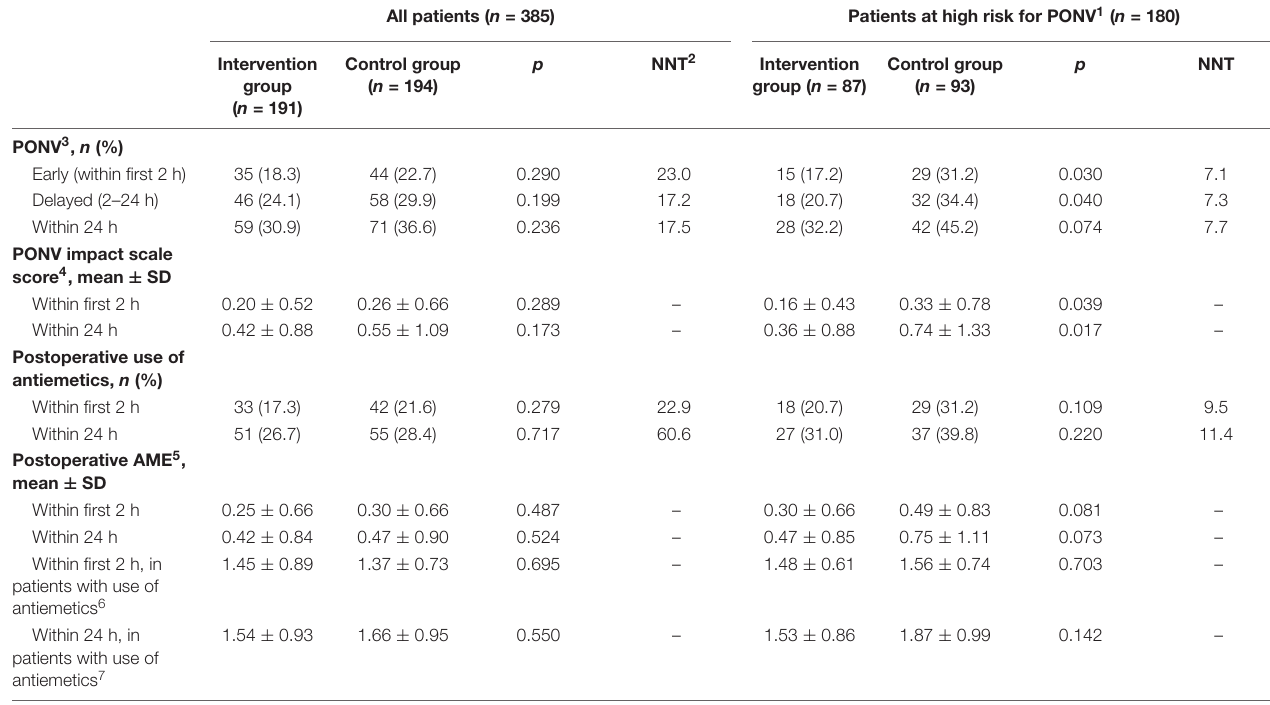
TABLE 2 | Outcome variables for all patients and subgroup of patients at high risk for postoperative nausea and vomiting, defined by a pre-operative Apfel-score of 3 or